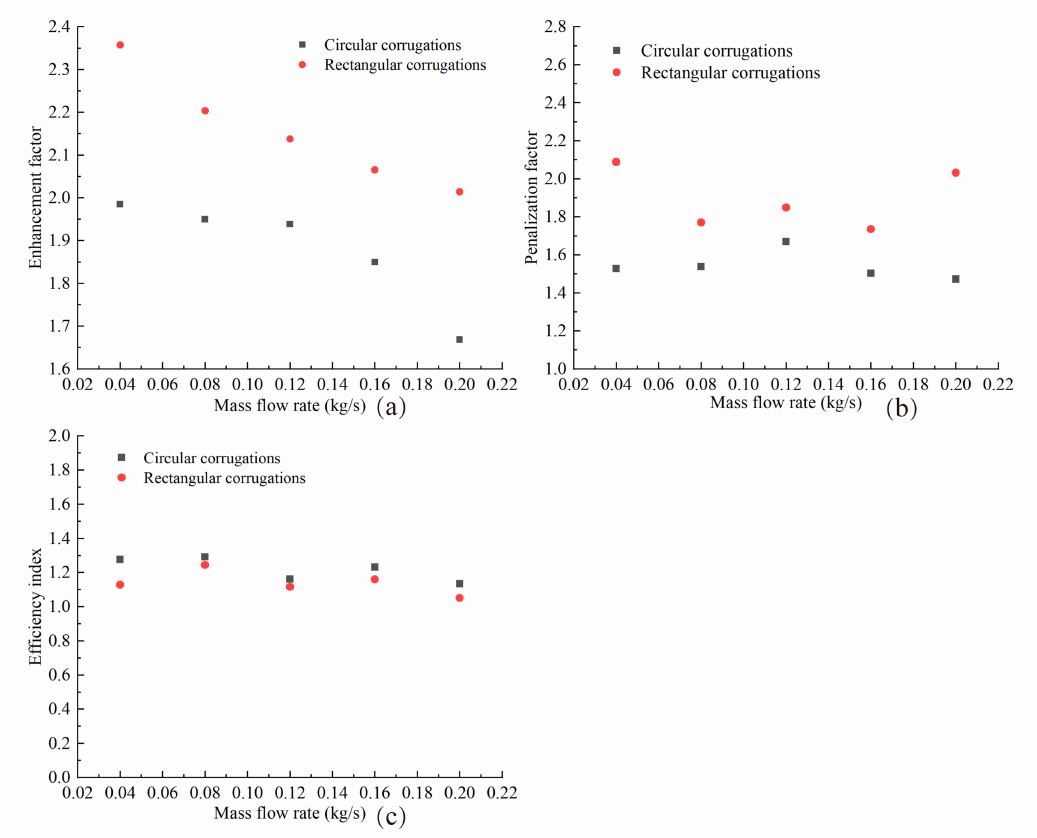
Figure 12. Variations in the enhancement factor E 1 ( a ), penalization factor P 1 ( b ), and efficiency index I ( c ) with mass flow